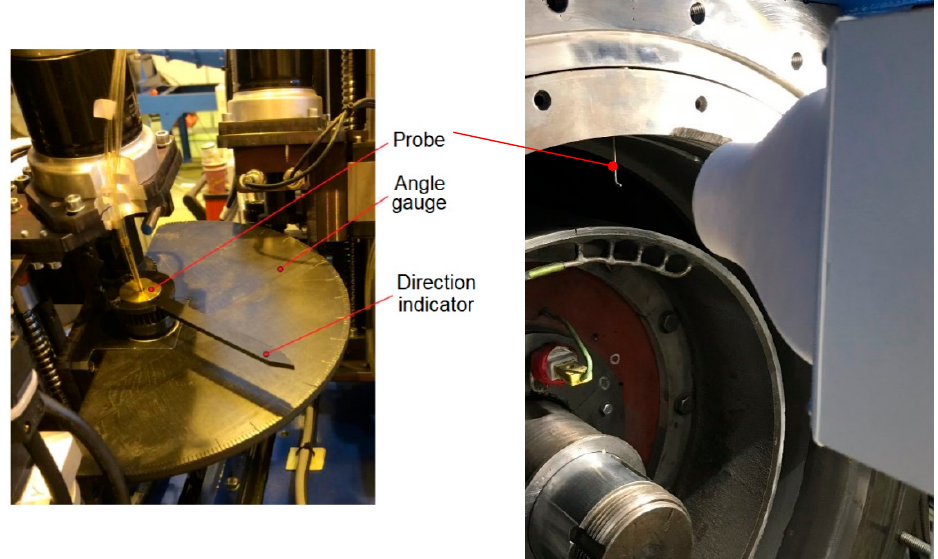
Figure 16. Geometric probe alignment ( left ); aerodynamic probe alignment ( right ).